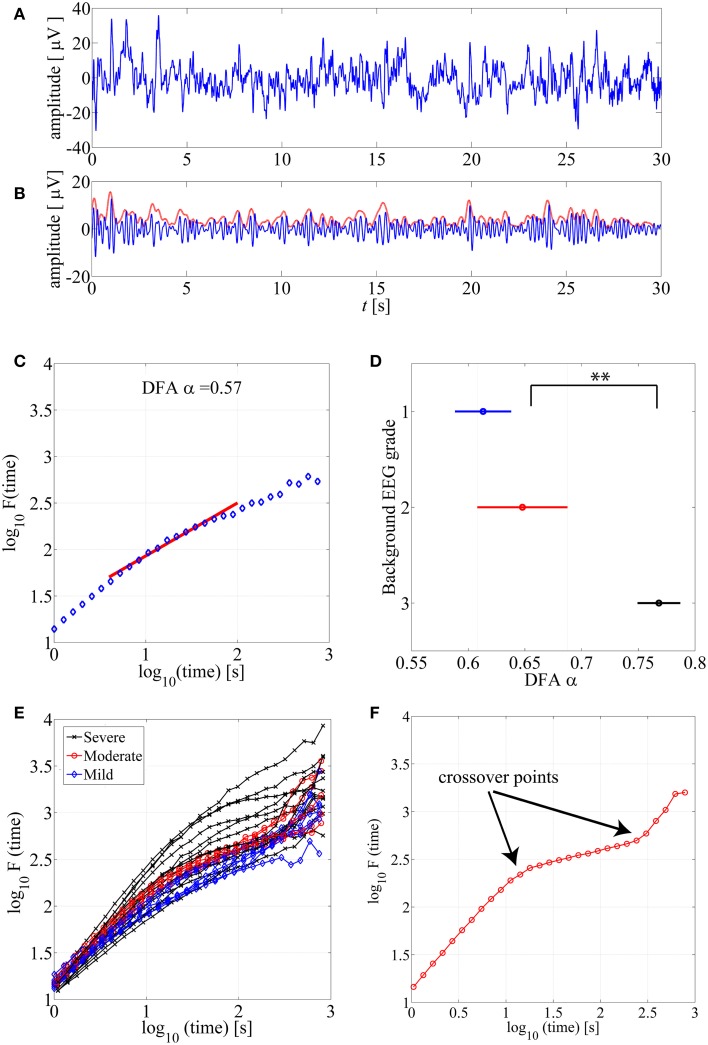
(A) An example of normal neonatal EEG signal with continuous background pattern. (B) The signal is band-pass filtered between 3–8 Hz (blue), and the instantaneous amplitude envelope (red) is calculated using Hilbert transform. (C) The DFA fluctuation function is presented along the Y axis, whereas the size of the windows analyzed in the DFA method are displayed in the X axis. The red line presents an example of linear fluctuation function that is here fitted for the time scale 10–60 s to obtain its slope, the DFA scaling exponent α. (D) DFA fluctuation functions are plotted for 15 min EEG epochs from different background EEG abnormalities (Mild-blue, Moderate-red, Severe-black). Statistically significant differences can be observed between different background EEG classes (**p < 0.01). This figure only shows examples of such EEG epochs where linear fit (R2 > 0.97) was confirmed. (E) Comparison of scaling exponent α between different background EEG grades shows a significant difference between grades 2 and 3. (F) An example of the DFA fluctuation function (moderate EEG grade) where clear existence of the crossover points are illustrated.